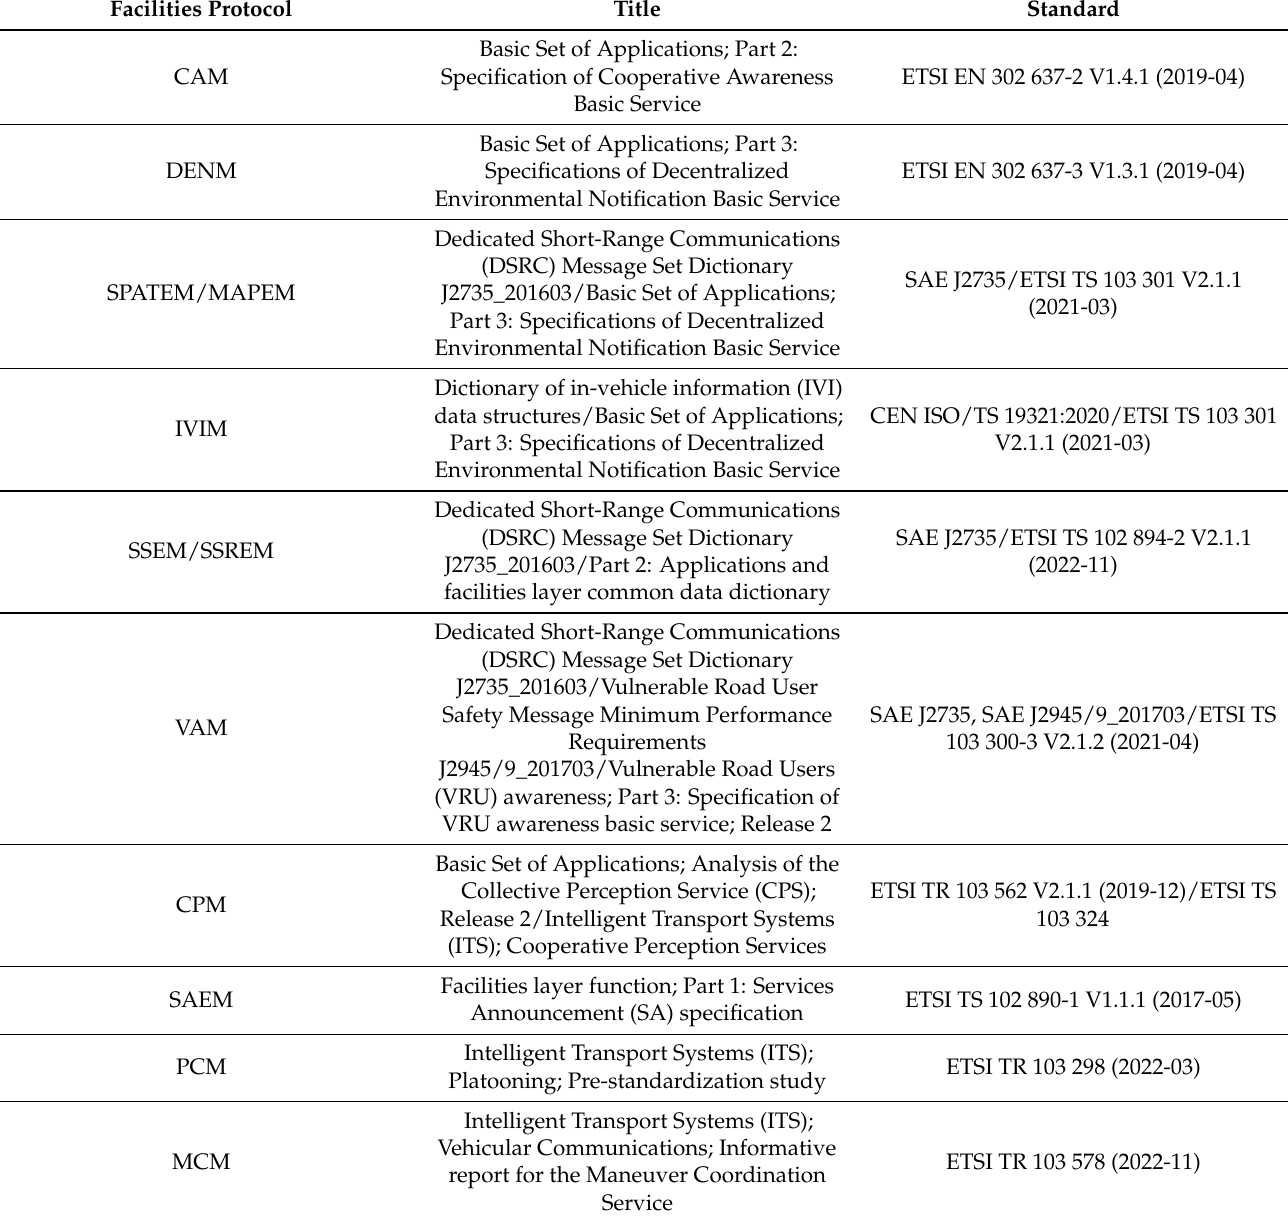
Table 1. Considered V2X protocols for cooperative perception and information